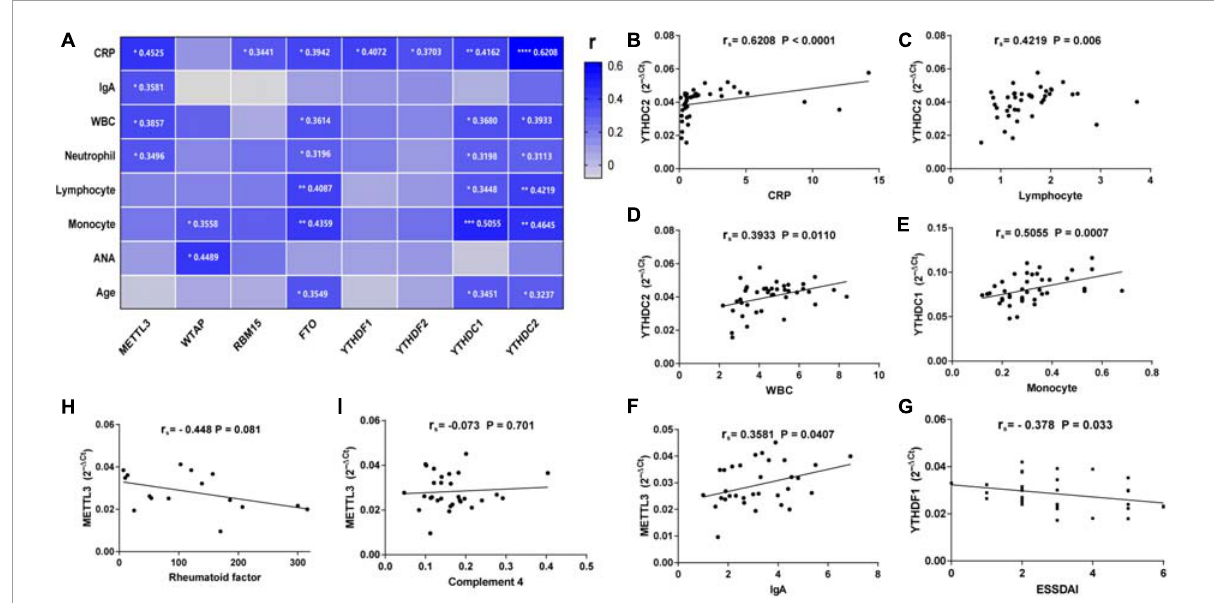
FIGURE4 Correlations between the expression of N6-methyladenosine-related genes and clinical data in patients with primary Sjögren’s syndrome (pSS). (A) METTL3 was positively correlated with C-reactive protein (CRP), immunoglobulin A (IgA), white blood cells, and neutrophils. WTAP was positively correlated with monocytes and antinuclear antibody (ANA). RBM15, YTHDF1, and YTHDF2 were positively correlated with CRP. FTO, YTHDC1, and YTHDC2 were positively correlated with CRP, white blood cells, neutrophils, lymphocytes, monocytes, and age. (B–F) Representative figures of positive correlations between m6A elements and clinical data in pSS. (G) The messenger RNA (mRNA) level of YTHDF1 was negatively correlated with the EULAR Sjögren’s syndrome disease activity index (ESSDAI) score. (H,I) No significant correlation was found between m6a elements and risk factors for the development of lymphoma in patients with pSS. CRP: C-reactive protein. * p < 0.05, ** p < 0.01, *** p < 0.001, and **** p <